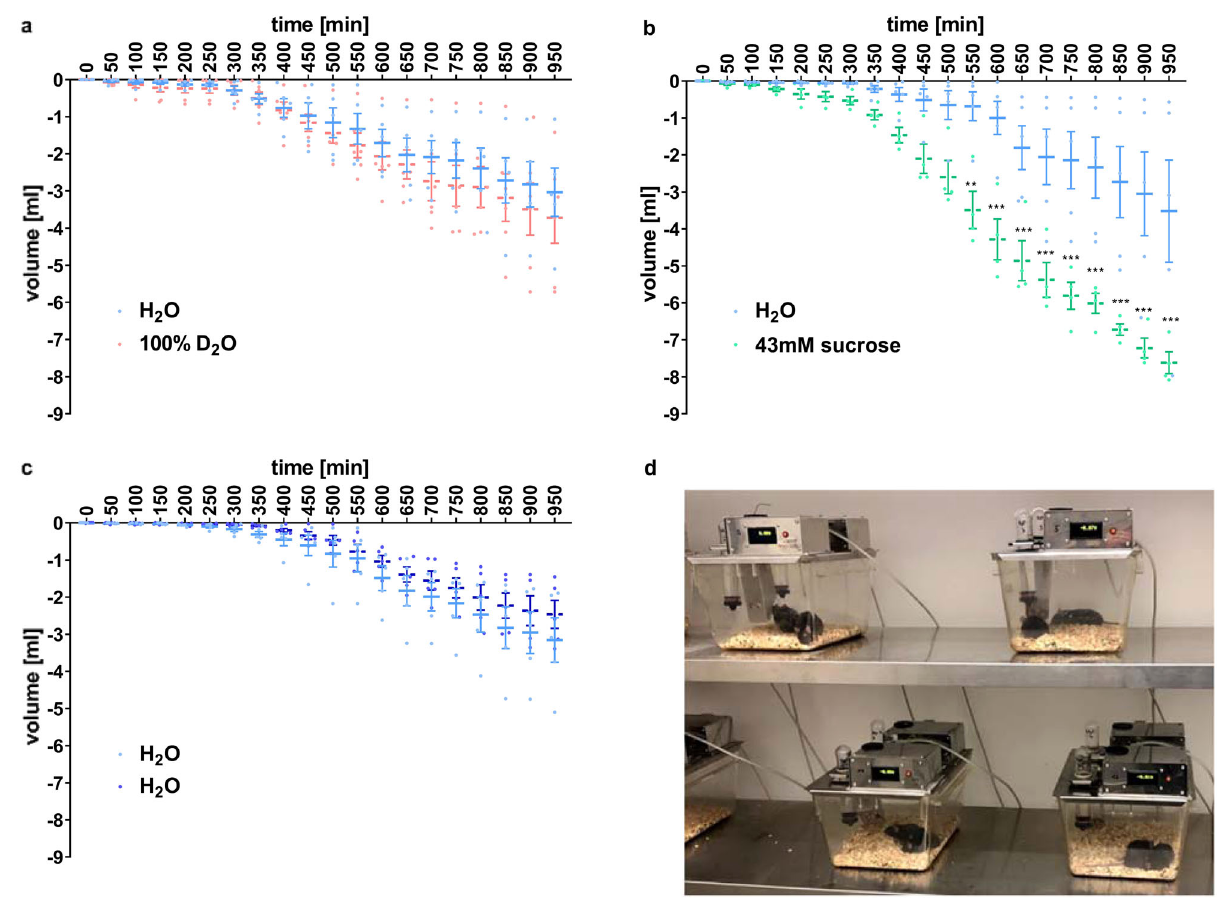
Fig. 3 Time-resolved volumes of water consumption by mice. a Volume consumption of D 2 O is not different from that of H 2 O ( n = 12). b Mice show strong preference to sucrose solution ( n = 10). Signi fi cance is ** p < 0.01, *** p < 0.001. c Volume consumption of the control group drinking H 2 O only ( n = 12). d Snapshot of the automatic drinking monitoring system. Mice were placed in groups of two in individual cages. Data are presented as the mean ± standard error of the mean (SEM). Statistical analysis was performed using two-way ANOVA with a Bonferroni ’ s multiple comparisons test.